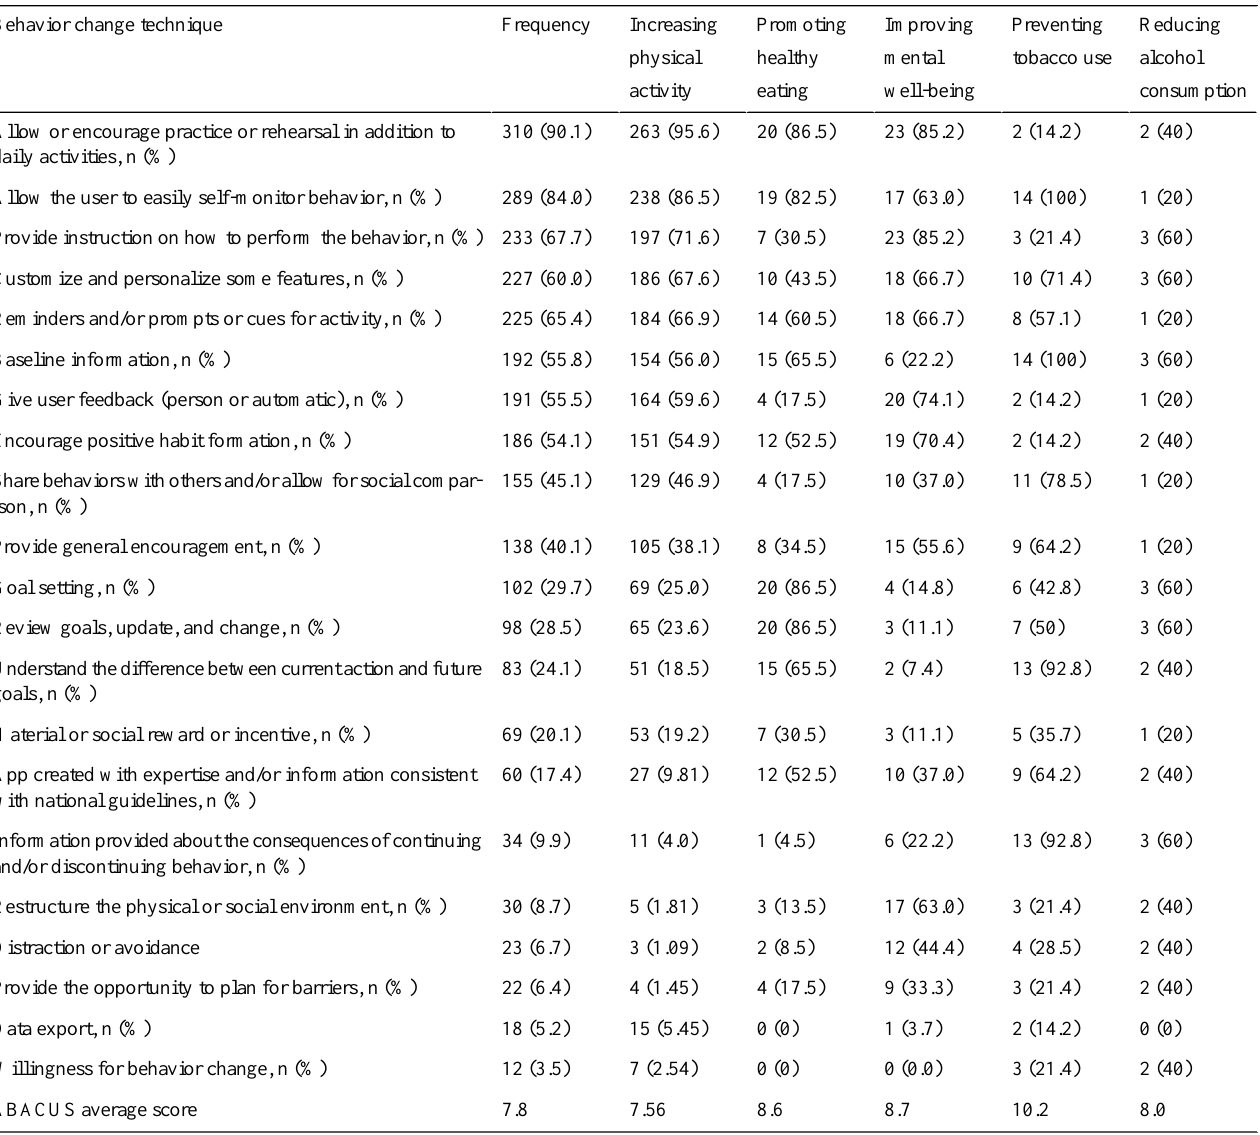
Table 3. Performance on App Behavior Change Scale (ABACUS) criteria (most to least frequently used).